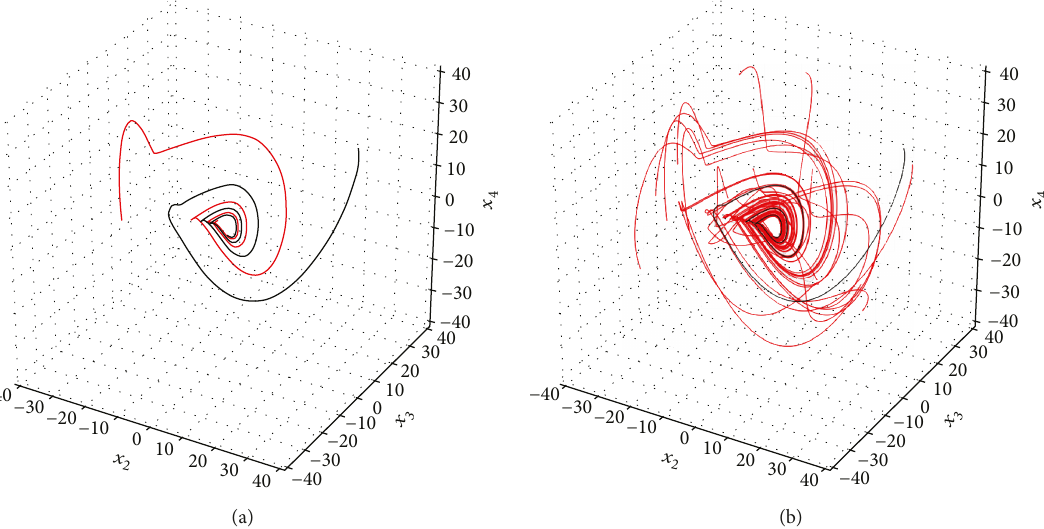
Figure 22: Feature distribution of training/testing data for component x trajectory. Black line: testing data. Red line: training data.